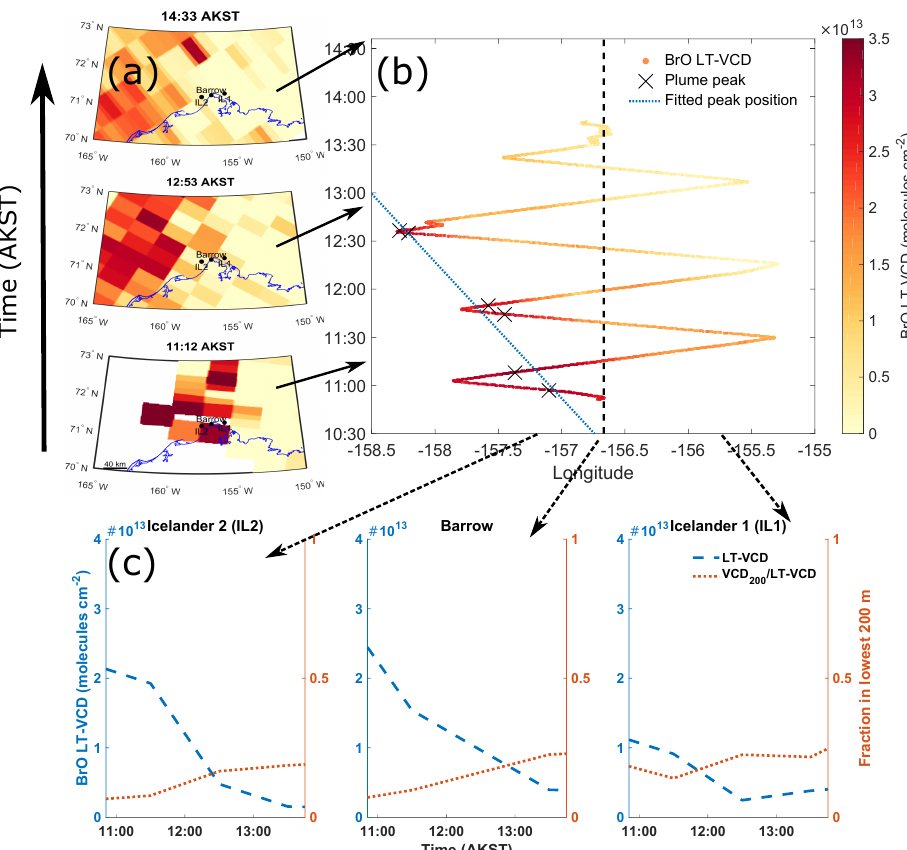
Figure 7. Summary of BrO plume motion over Utqia˙gvik on 13 March. (a) BrO plume motion from east to west as observed by individual overpasses of the GOME-2 satellite as well as the locations of ground-based measurement sites. The blue line denotes the Alaska coastline. (b) BrO plume motion as observed by airborne DOAS. The dashed black line indicates the longitude of Utqia˙gvik. The black crosses show the observed peak BrO positions for each transect, while the blue line gives the fitted plume peak location as a function of time. (c) Ground-based MAX-DOAS measurements at each site during the flight arranged from west to east.